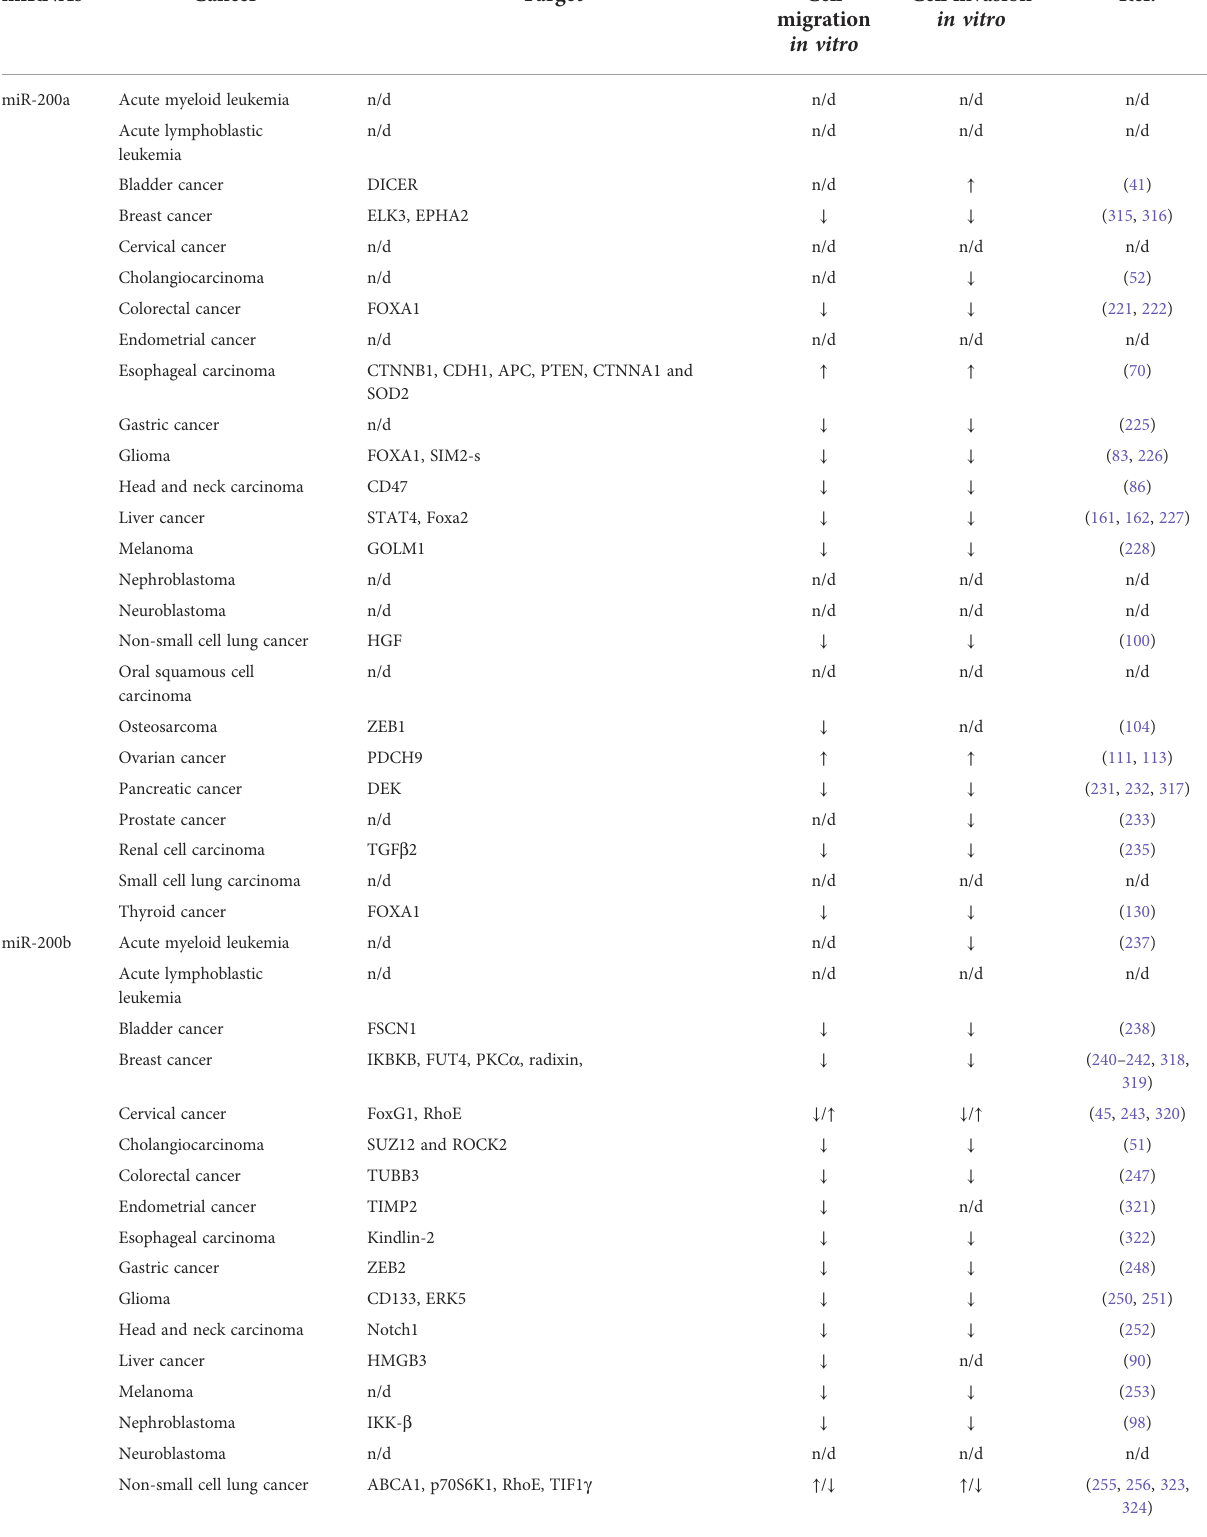
TABLE 4 Members of the miR-200 family regulating cancer cell migration and invasion. miRNAs Cancer Target Cell